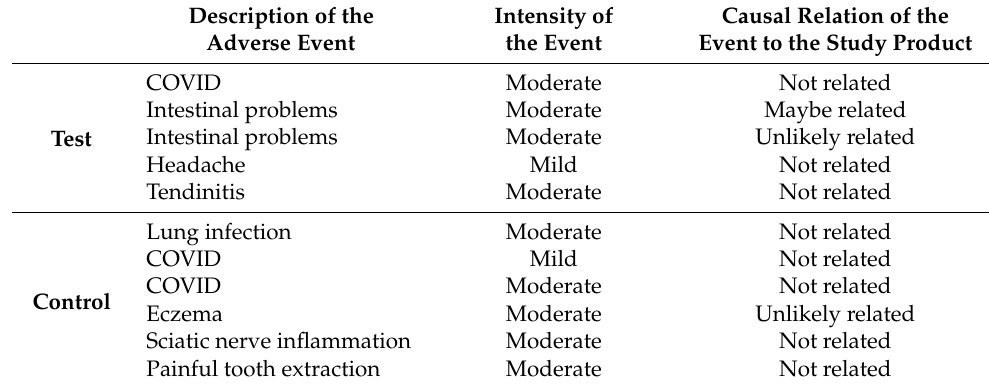
Table 1. Description of mild and moderate adverse events observed in the Test and Control groups.